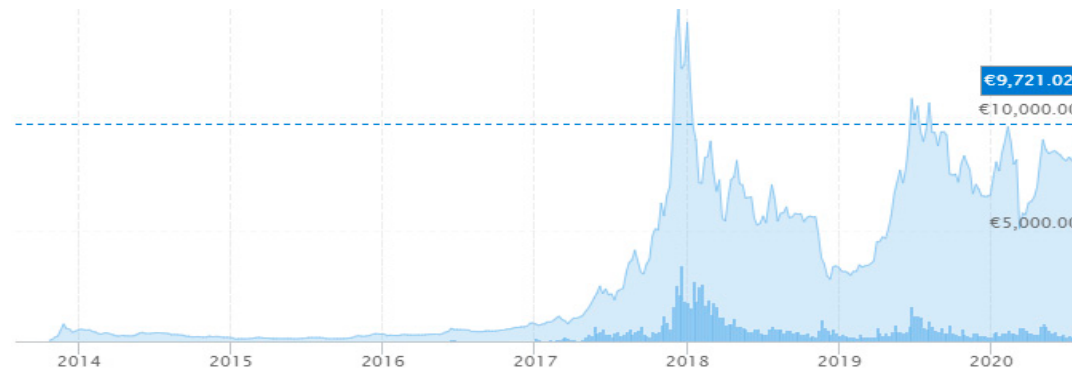
Figure 6. The evolution of Bitcoin in Romania, 2014–2020. Source: bitcoinromania.ro.